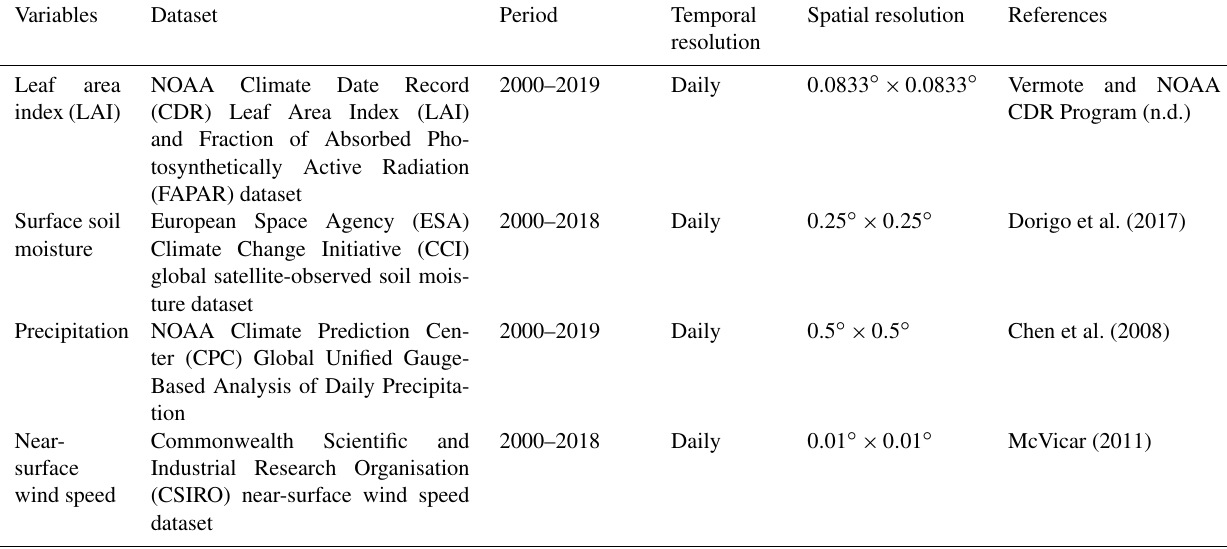
Table 1. Summary of the observational datasets for environmental variables applied in the current analyses across